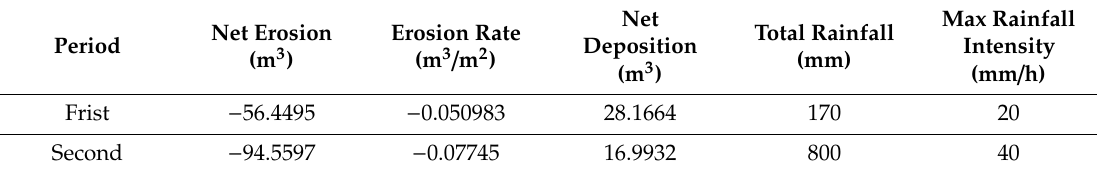
Table 4. Degree of erosion factors in the frist (February 24–May 26, 2011) and second (May 26–August 03, 2011)